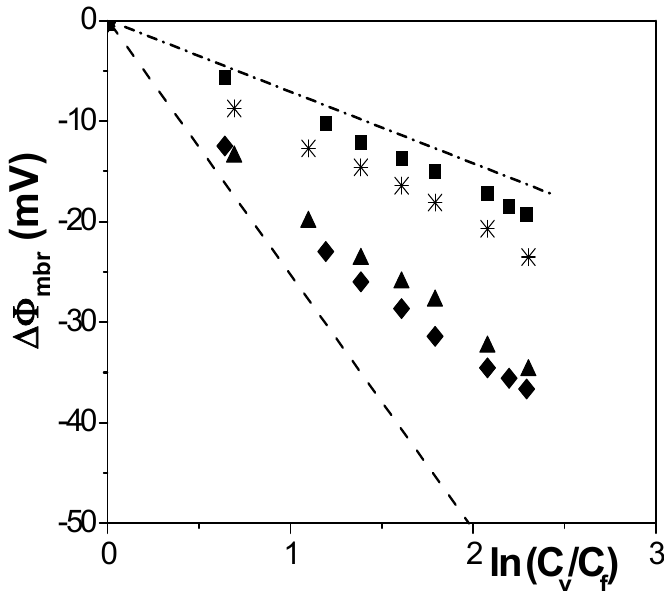
O (▲), and Al-Ox/SiO 2 3 2